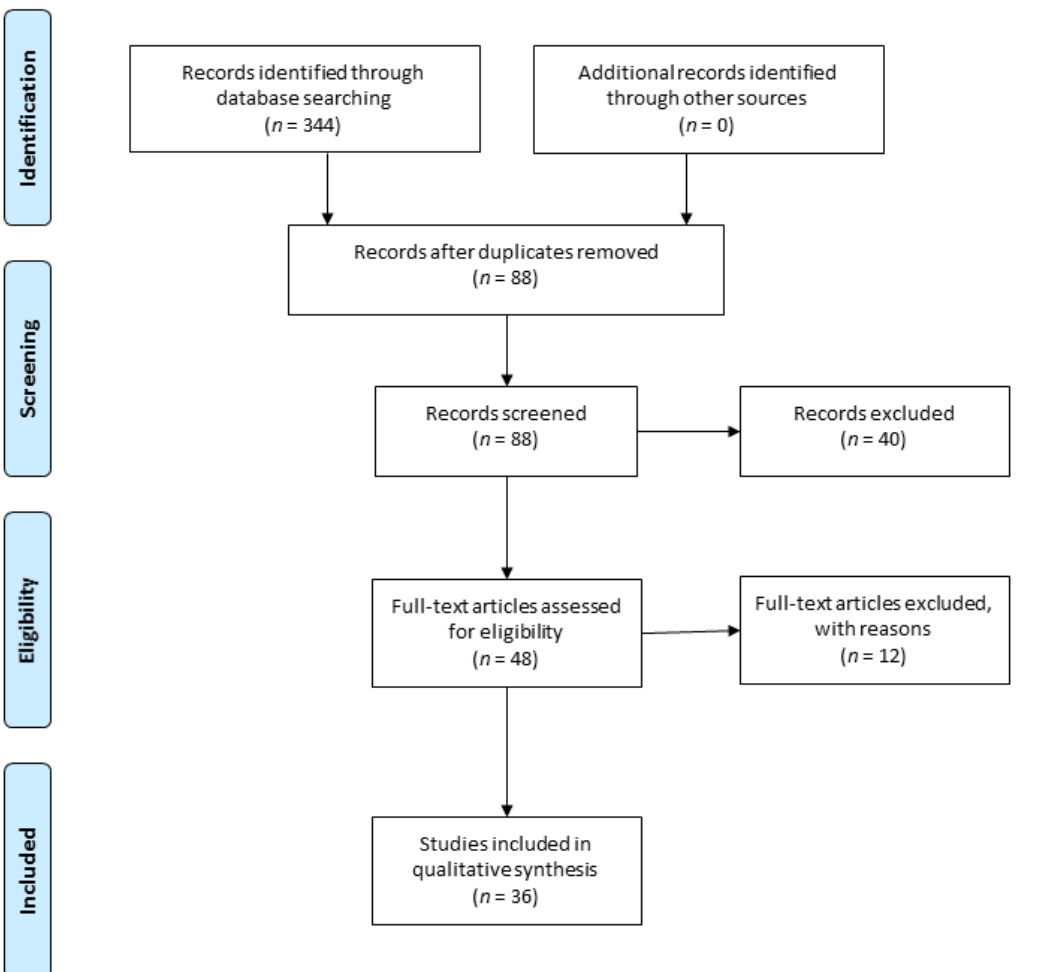
Figure 1. PRISMA diagram of the study selection process [43]. “ n ” signifies the number of publications.